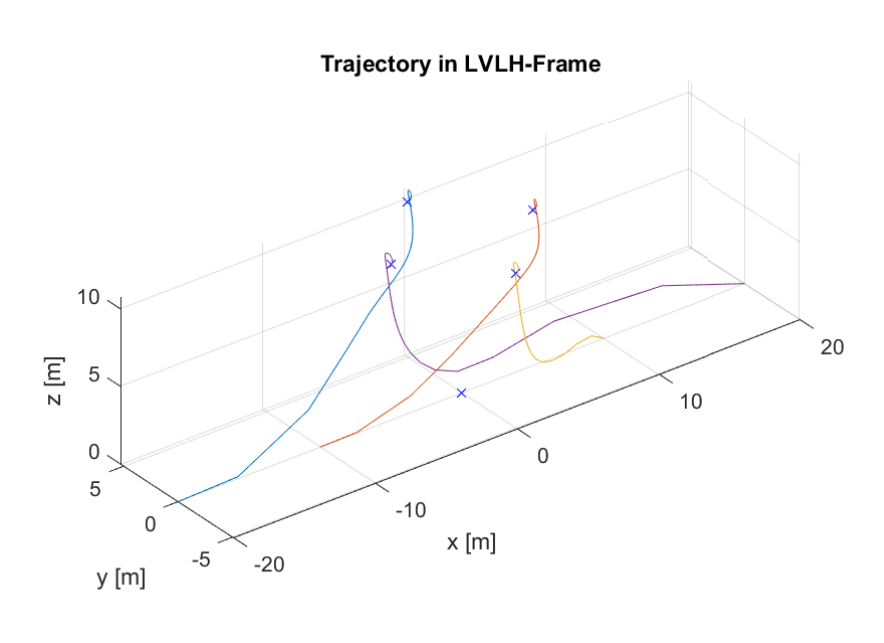
Figure 17. 3D plot of the trajectories of the five satellites subject to the presented robust consensus-based controller starting on v-bar ( − 20, − 10,10,20,0 m). One satellite is fixed at the origin and uncontrolled. Still, the other satellites adjust their states to form the desired